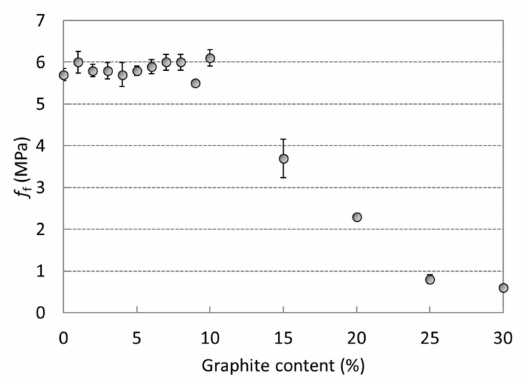
Figure 4. Flexural strengths of AAS composites with 0 wt%–30 wt% of graphite powder (standard deviations are presented as error bars).